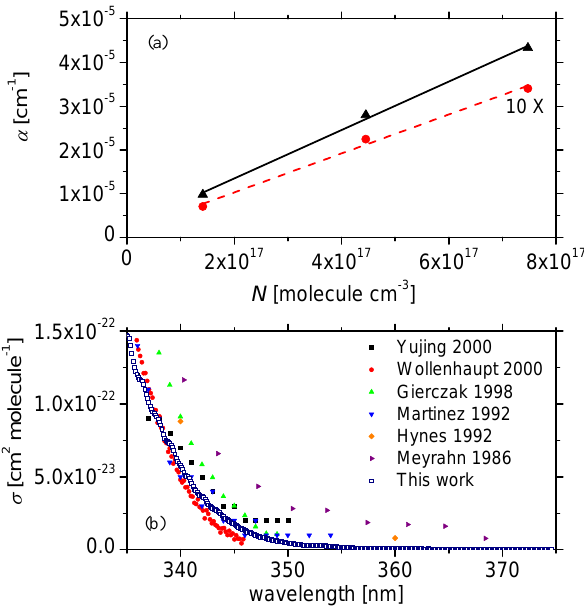
centration at 340nm (black triangles) and at 350nm (red circles). Correlation coefficients are 0.996 and 0.987, respectively. (b) Ace- tone absorption cross-section of this work and of several literature